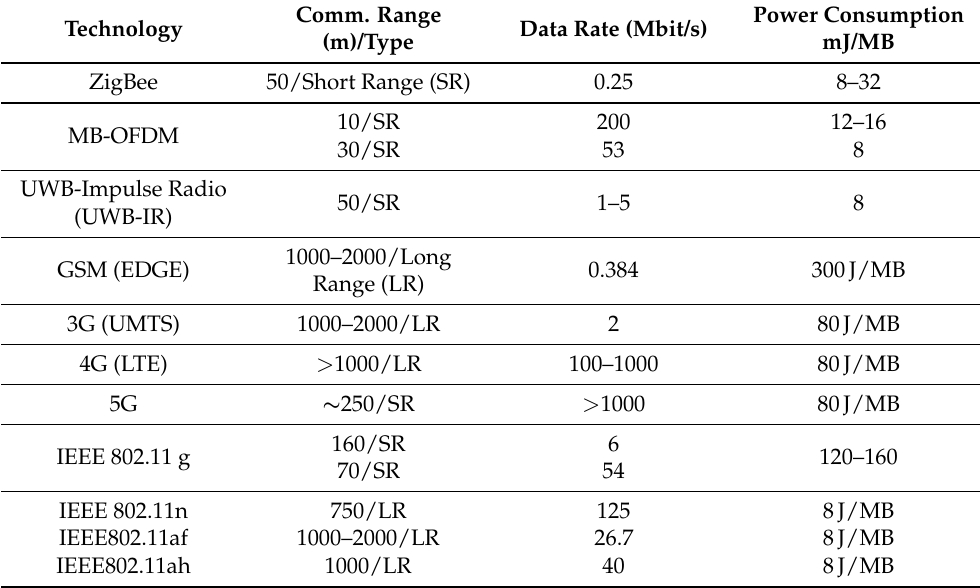
Table 2. Technologies for wireless seismic survey